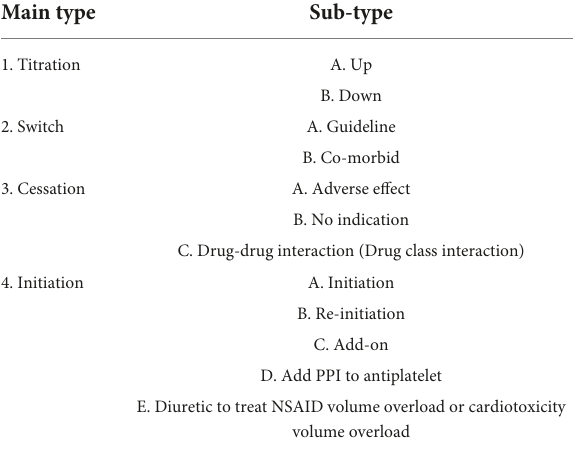
TABLE 3 Types of drug interventions. TABLE 4 Frequency of the main types of drug interventions by the heart